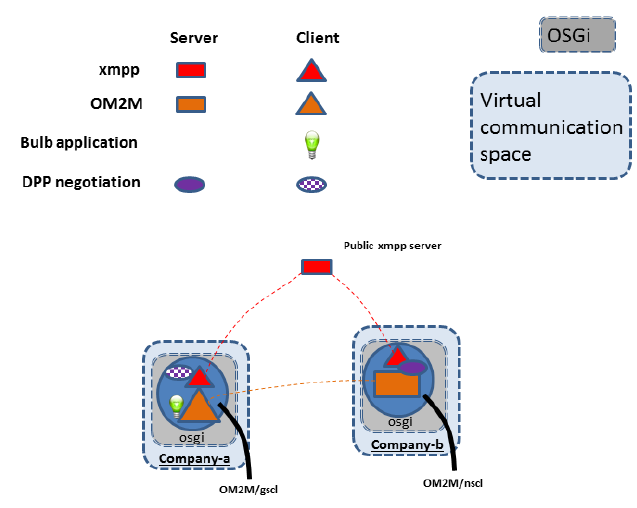
Figure 24. Data plane negotiation in the OneM2M case.